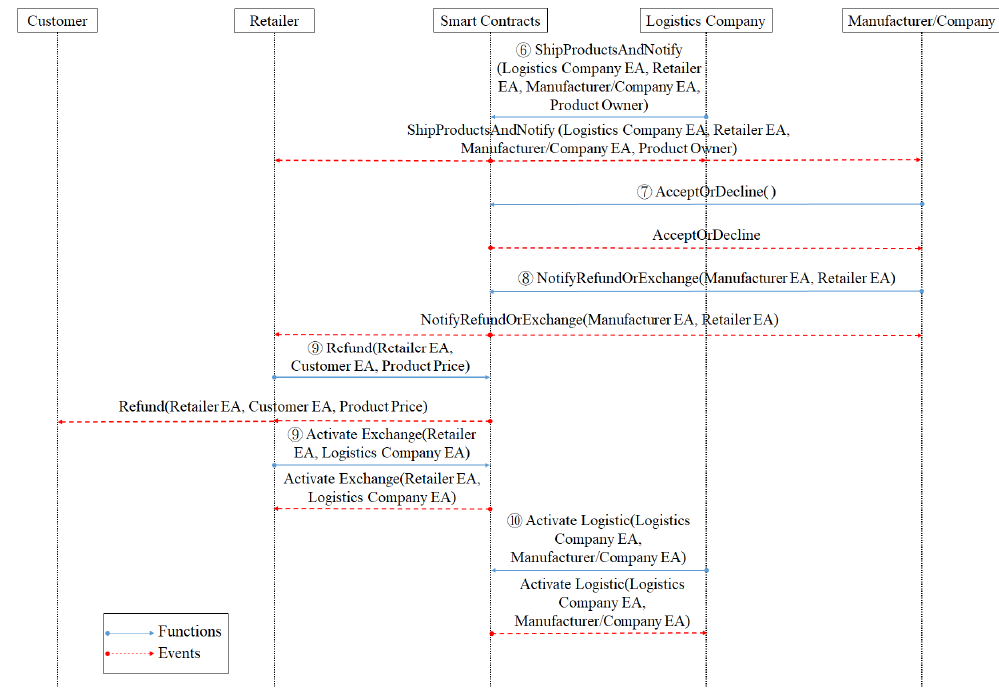
Figure 5. System Sequence Diagram 2.